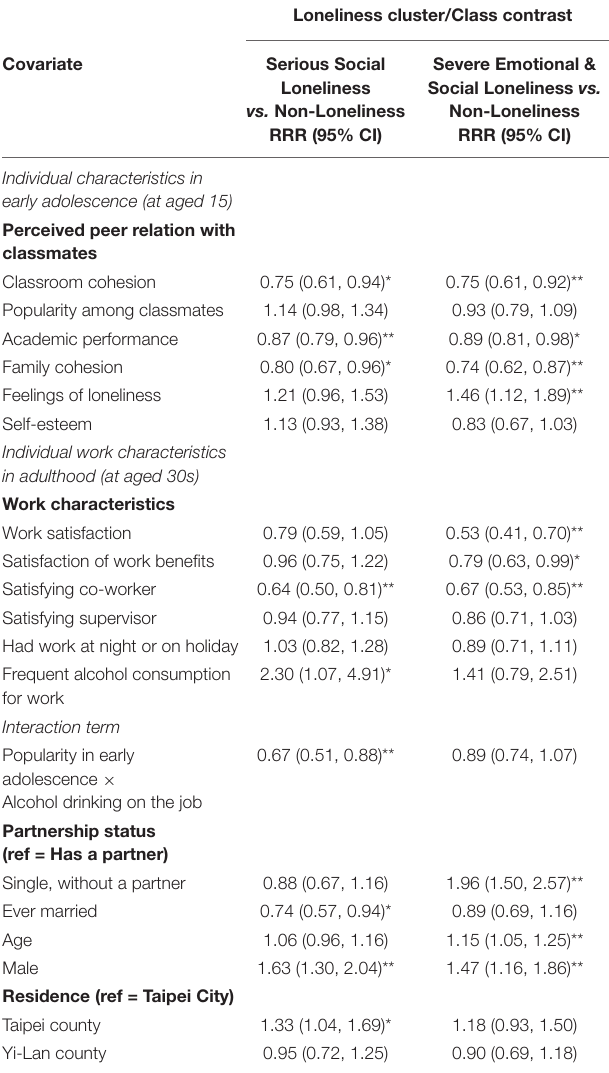
TABLE 3 | Multivariate multinomial logistic regression results for work characteristics associated with latent structure of loneliness in employed young people, Taiwanese Youth Project ( N =